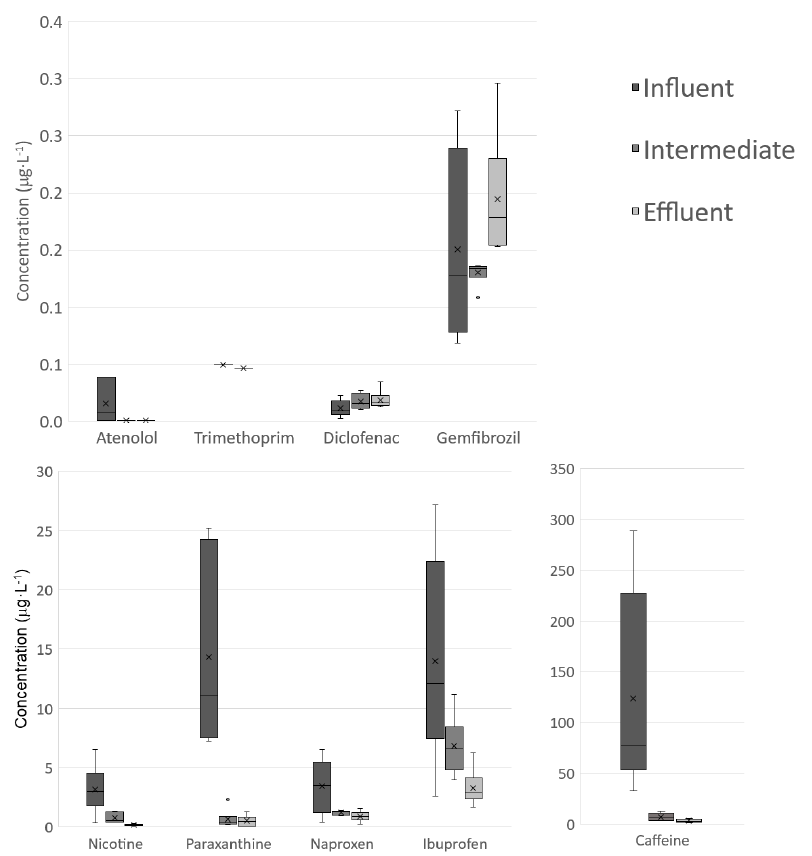
Figure 4. Boxplot of concentrations of analyzed pharmaceuticals at the three sampling points.